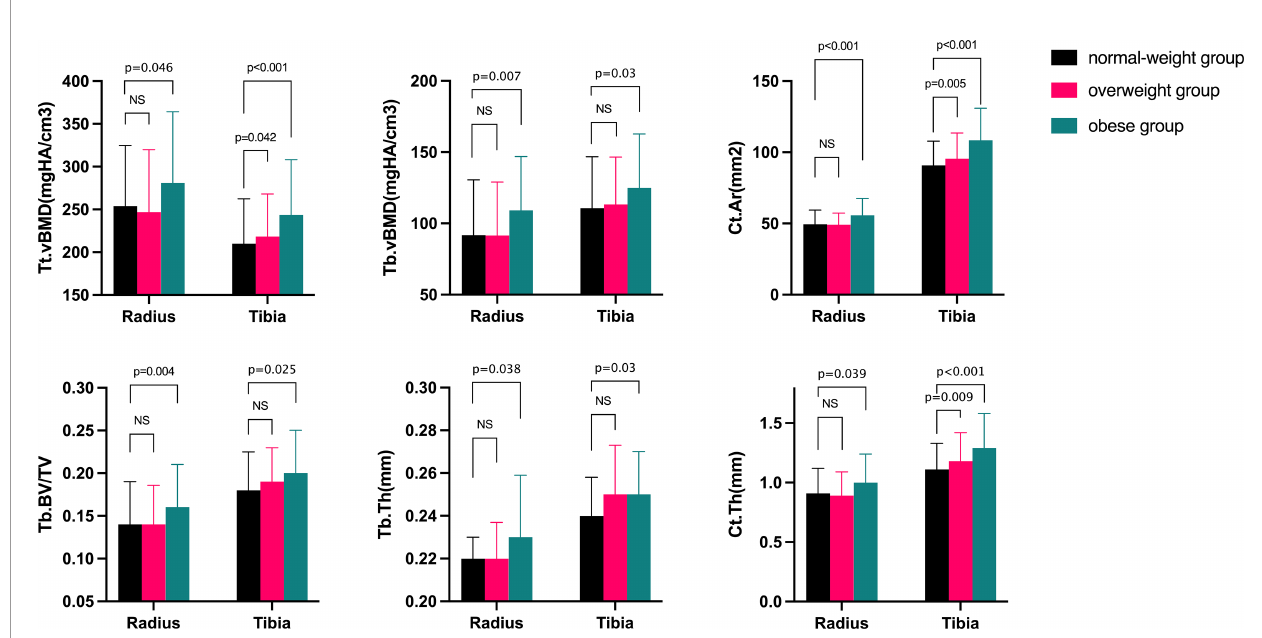
FIGURE 1 | Comparisons of bone microarchitecture at the distal radius and tibia after adjusting for confound variables in normal-weight, overweight, and obese women. Ct.Ar=cortical area; Tt.vBMD=total volume bone mineral density; Tb.vBMD=trabecular volume bone mineral density; Tb.BV/TV=trabecular bone volume fraction; Tb.N=trabecular number; Tb.Th=trabecular thickness; Ct.Th=cortical thickness. The p-value was adjusted for age, current smoking, alcohol intake, supplementations of calcium or vitamin D, milk drinking, and physical activity. NS, no signi fi cant.